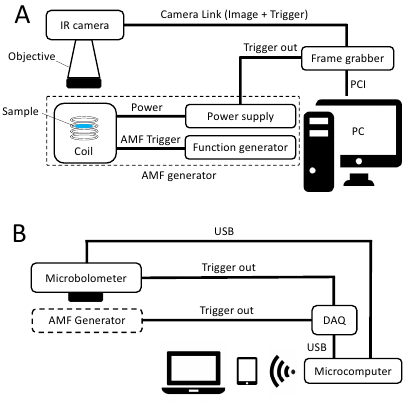
Figure 1. Measurement apparatus designed to investigate thermal signals of magnetic NPs in an AMF. ( A ): Schematic diagram of the laboratory setup. The alternating magnetic field is generated using a commercial coil system (MagnethermTM V1.5, nanoTherics, Warrington, UK). The frame grabber card transfers the temperature images in real time to a personal computer for further processing, and it synchronizes the stimulation. ( B ): Schematic description of a potential alternative affordable setup. The temperature images acquired by a microbolometer camera are sent in real time via USB to a microcomputer for processing without the need of an additional frame grabber. A web server running on the microcomputer allows for a wireless data transfer to a laptop or tablet. As the camera is operating on a rolling frame basis it acts as a master clock sending trigger signals to the stimulation